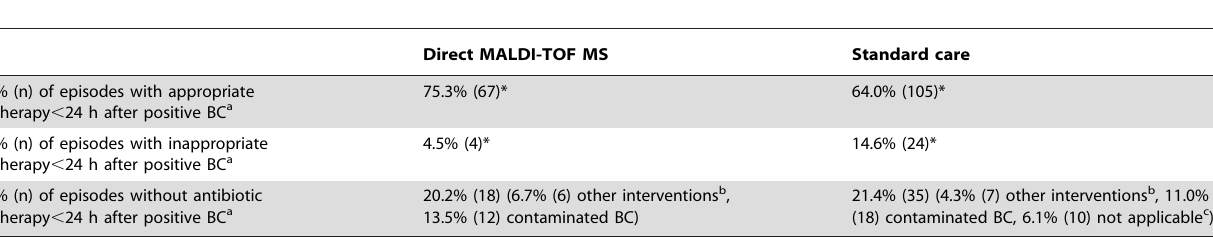
Table 4. Effect of direct MALDI-TOF MS on proportion of appropriate treatment.